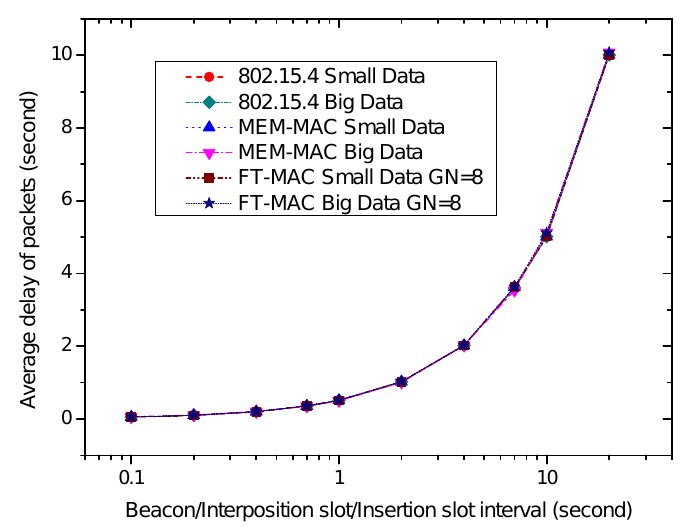
Figure 19. The effect of the beacon/interposition/insertion intervals on average frame delay.